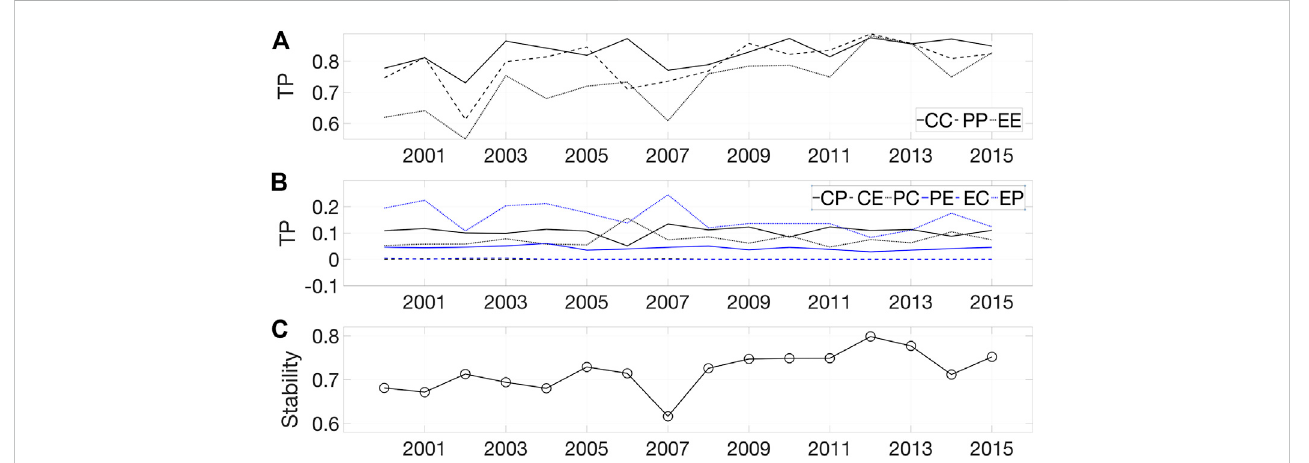
FIGURE 10 Transition probability (TP) of (A) CC/PP/EE blocks and (B) off-diagonal blocks and (C) the structural stability of the board network. Structural stability is estimated by Eq. 1 in the transition probability matrix between time t and time t+1 calculated by a core – periphery structure for each year (2000 – 2015). Structural stability via the core – periphery boards changed to prepare fi nancial information before the 2007 – 2009 fi nancial